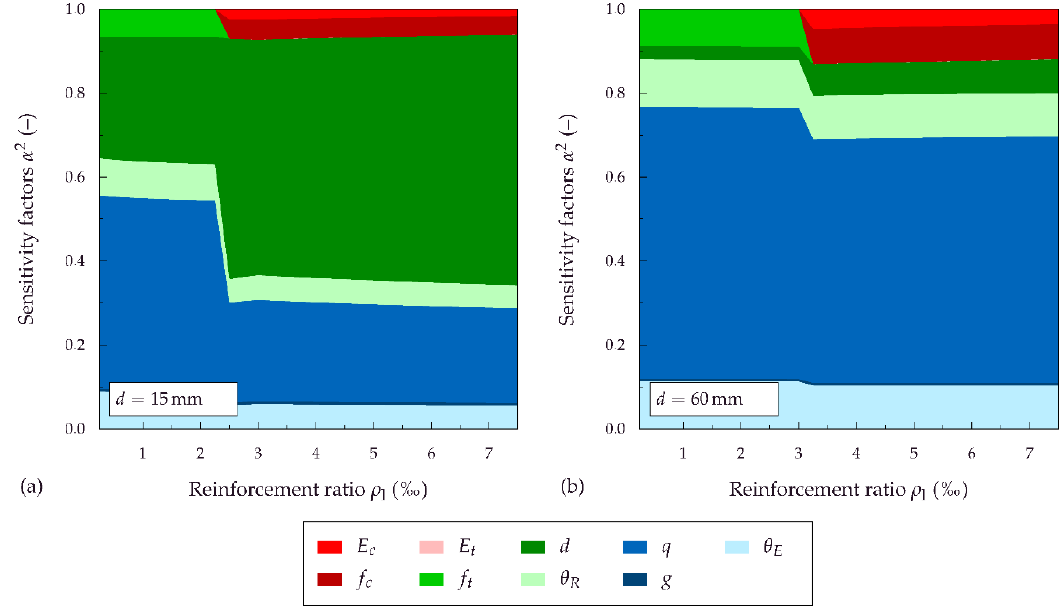
Figure 13. Sensitivity factors calculated for γ T = 1.3 according to FORM: ( a ) effective depth d = 15 mm; ( b ) effective depth d = 60 mm.